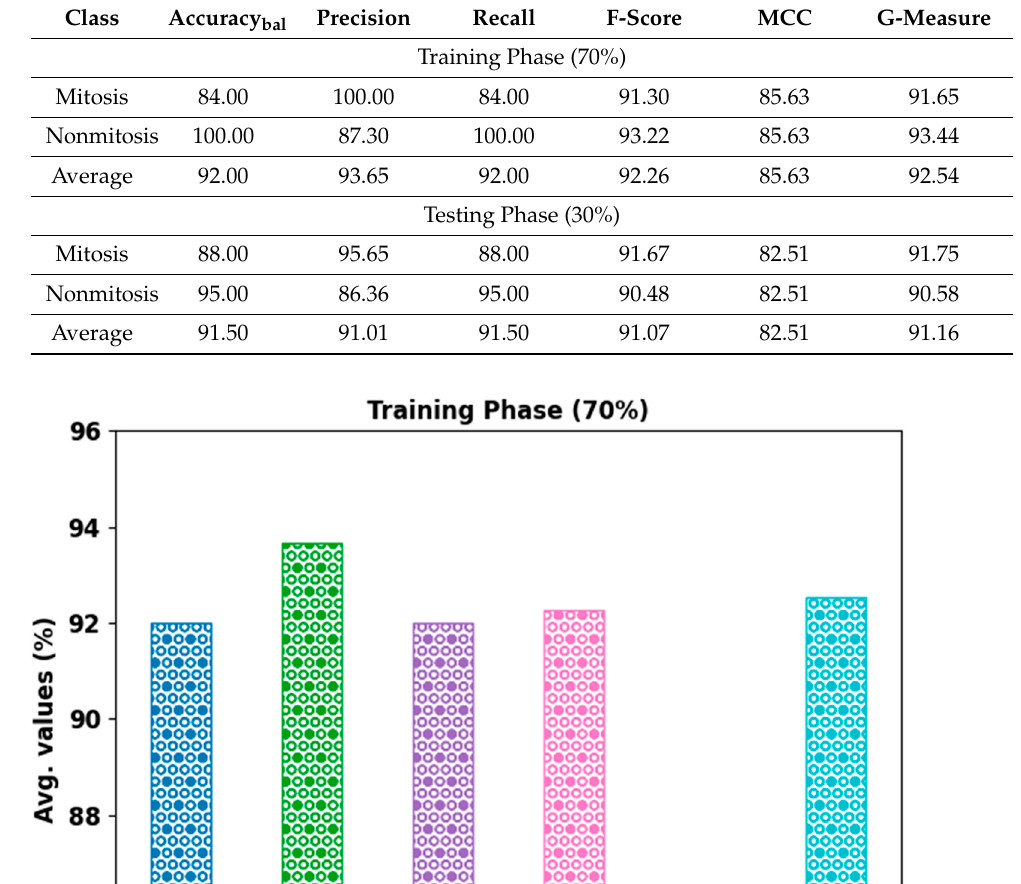
Table 3. Mitosis classification outcome of AHBATL-MNC approach under 60:40 of TR/TS databases.